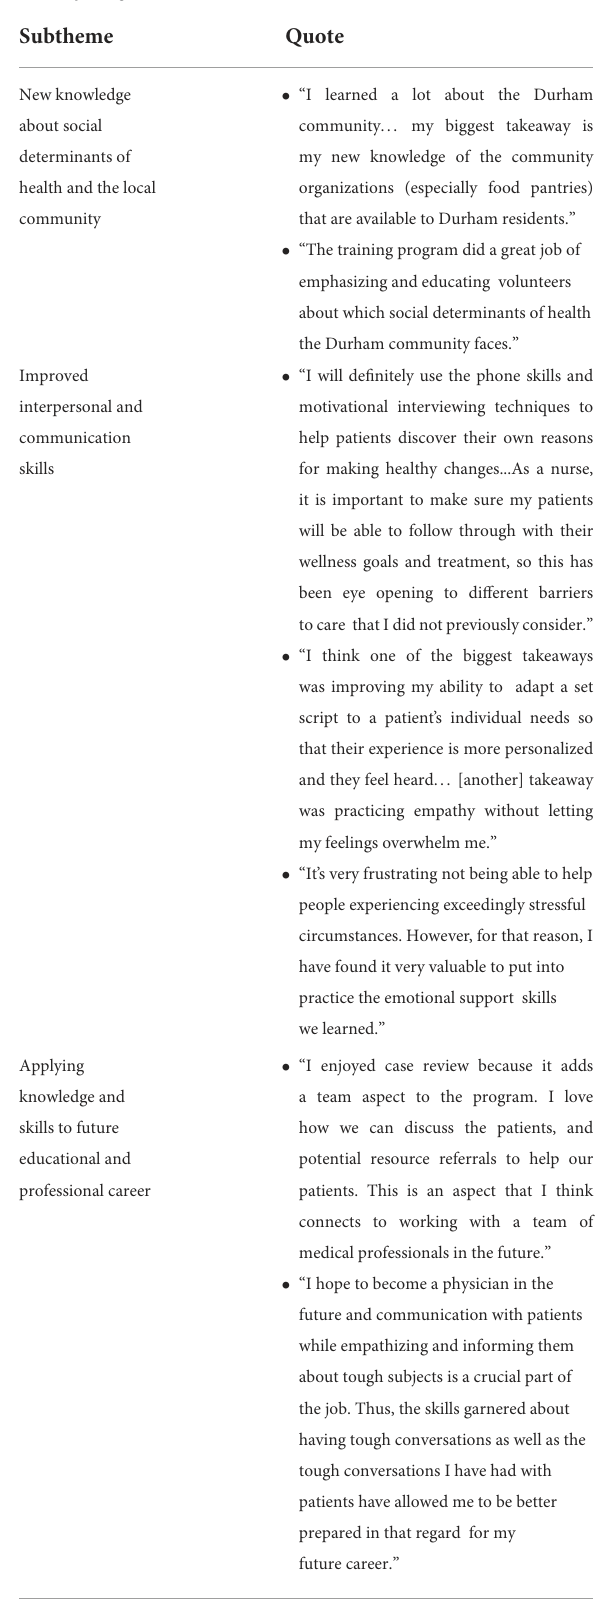
TABLE 3 Representative quotes on knowledge gained and skills developed by learners.